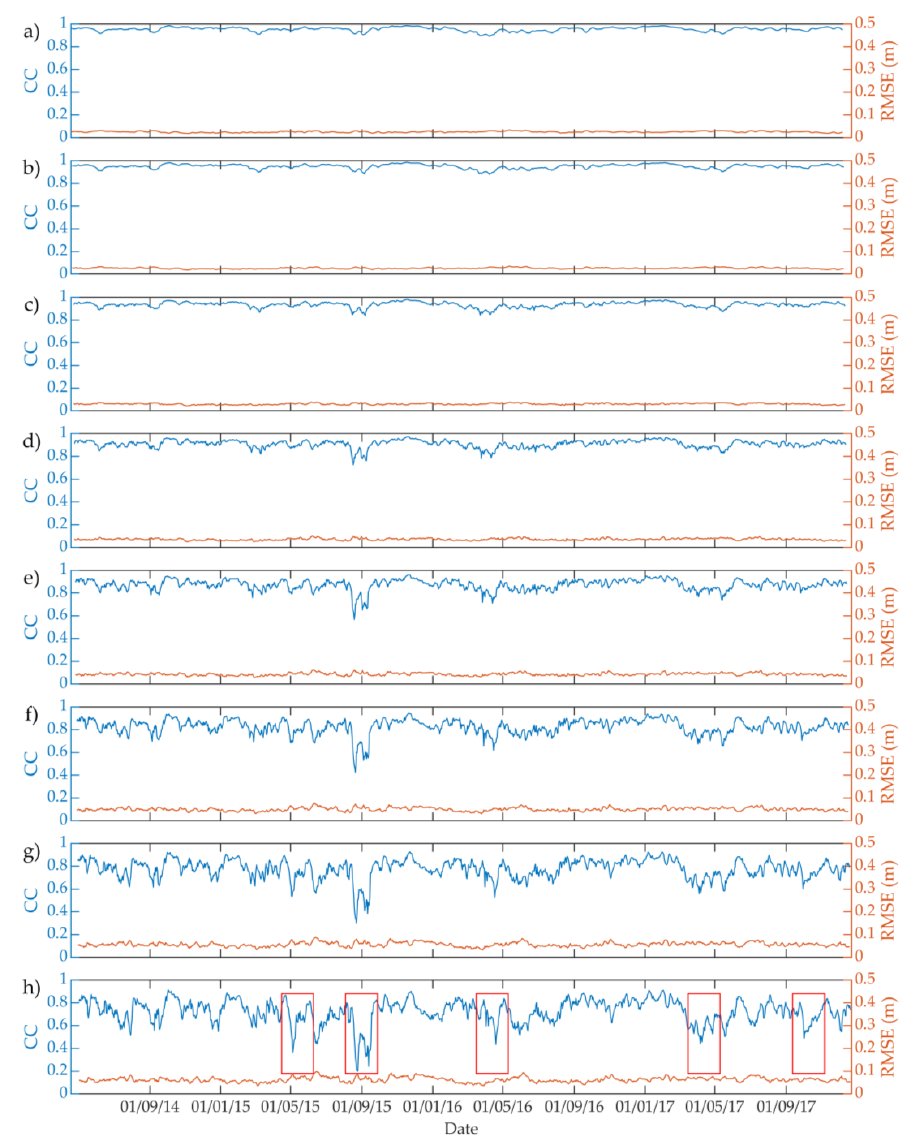
Figure 6. The correlation coefficient and RMSE between the observed and predicted SLA in the study area from 18 April 2014 to 31 December 2017 with a 15-day ahead daily sliding prediction window using 35 PCs. The blue line represents correlation coefficient, and the orange line represents RMSE. From ( a – h ) represent the predictions at day 1, day 3, day 5, day 7, day 9, day 11, day 13 and day 15, respectively. The red box is the part where the correlation coefficient oscillation